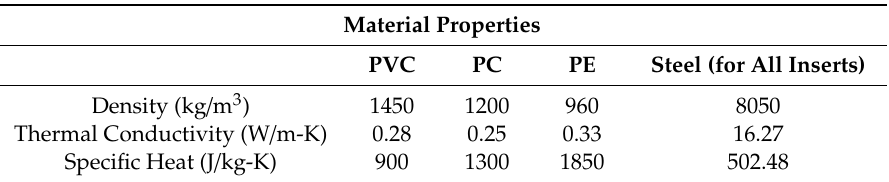
Figure 11. The effect of different materials on temperatures at 0 m and 20 m, at v inlet = 3.53 m/s. Figure 11. The e ff ect of di ff erent materials on temperatures at 0 m and 20 m, at v inlet = 3.53 m /